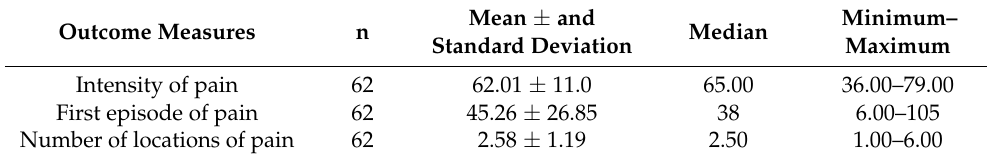
Table 1. Results of the initial evaluation of pain.